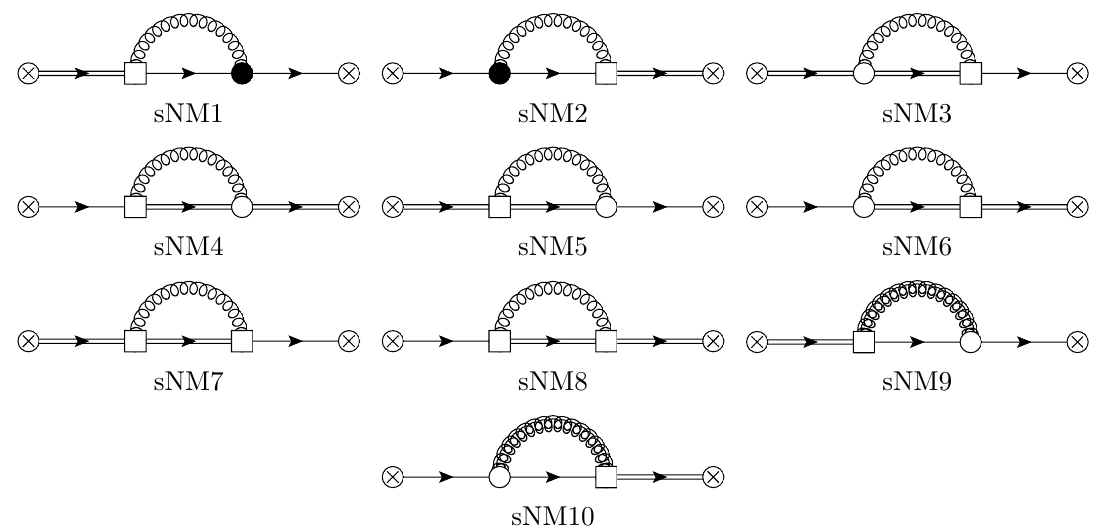
Figure 7. New next-to-leading order diagrams for the sNMGF evolved fermion 2-point function. Combined with the diagrams from figure 4 and figure 10 they represent the full sNMGF evolved fermion 2-point function, which is rendered finite by multiplying with the renormalization factor Z χ from